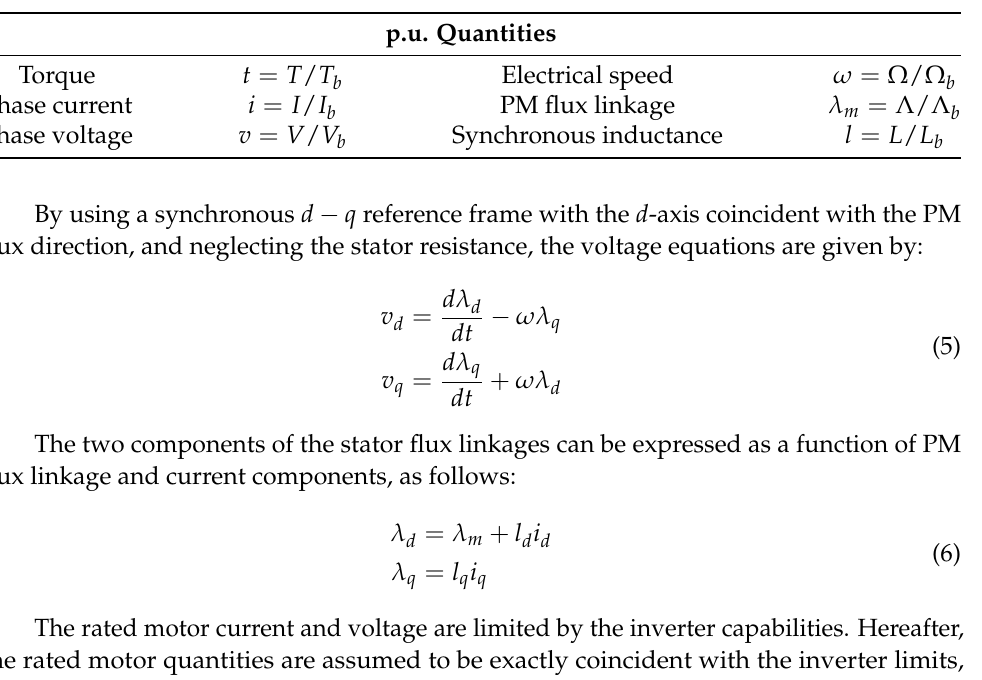
Table 1. Normalized quantities.